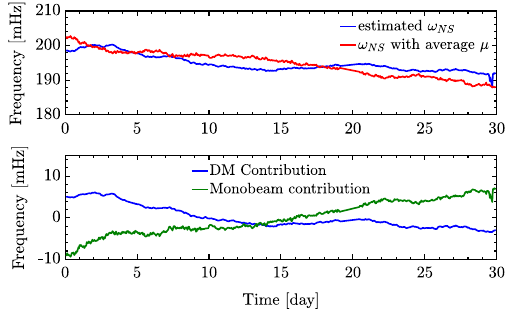
Fig. 5 Top: ω ns evaluated through the best-fit procedure and the one calculated assuming average losses. Bottom: the contribution using the DM and PH 2 signals to follow the time behaviour of the losses μ